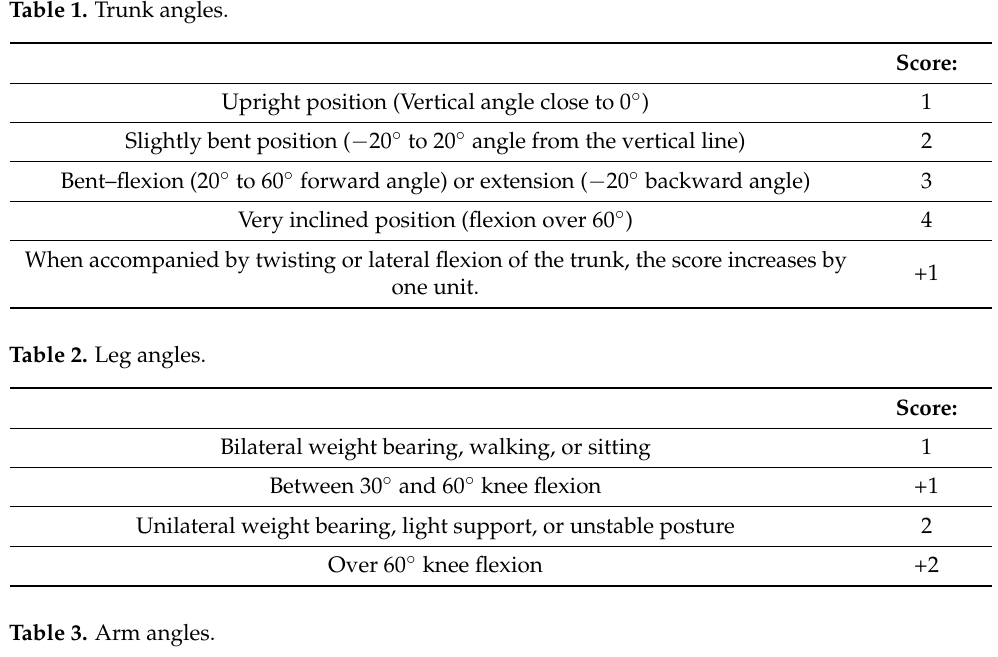
Score: Between 0 ◦ and 20 ◦ flexion/extension from the vertical line 1 Between 21 ◦ and 45 ◦ flexion or >20 ◦ extension from the vertical line 2 Between 46 ◦ and 90 ◦ flexion from the vertical line 3 Over 90 ◦ flexion from the vertical line 4 When accompanied by the abduction or the rotation of the shoulder +1 When accompanied by the raising of the shoulder +1 When the posture is gravity assisted − 1